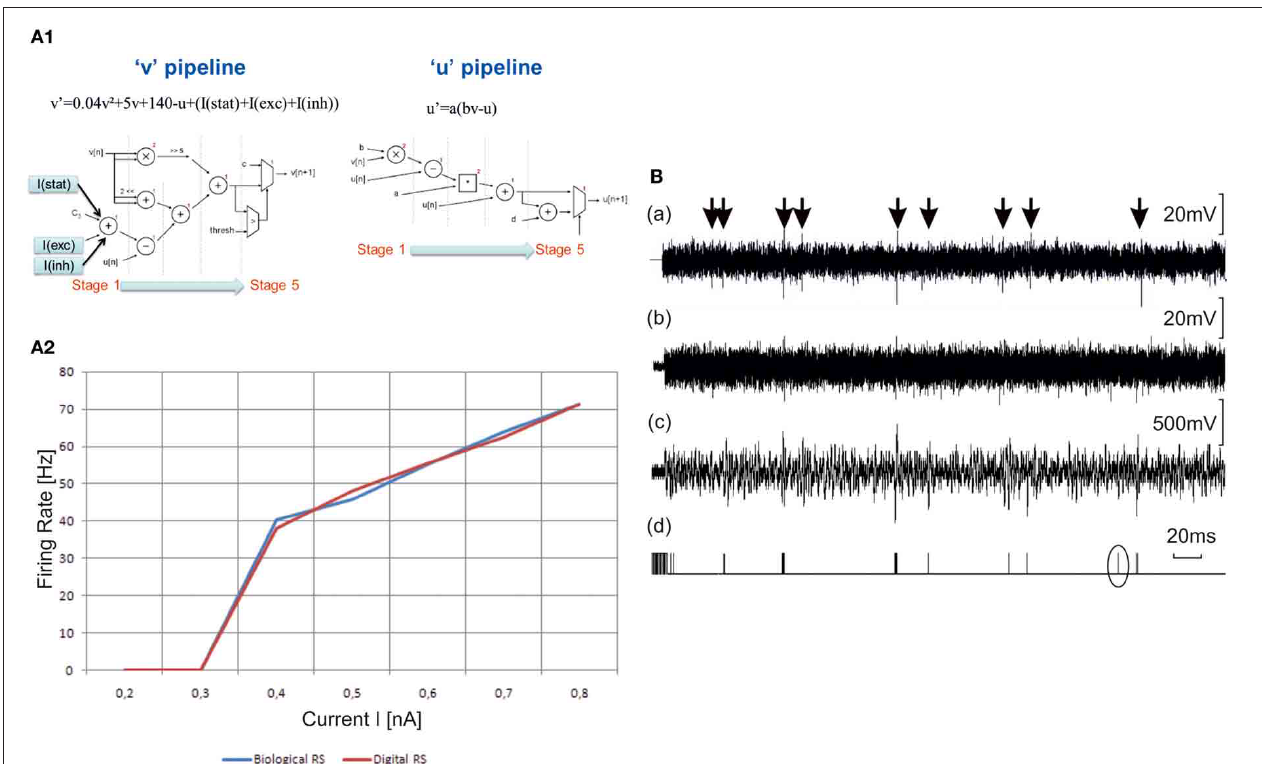
to Noise Ratio. This step was added to stress the capability of the system to detect action potentials in difficult conditions. Third row—(c) . Output of the stationary wavelet decomposition preprocessing module. We used a Haar mother wavelet with 16 bits fixed point computation. The output signal is the sixth level detail output of the decomposition tree. Fourth row—(d) . Binary output of the detection module. This output is the result of a threshold applied to the signal in (c). The threshold is computed from the standard deviation of the first level detail output of the wavelet decomposition tree. The emphasized detected spike is a false positive. This shows that the signal (b) represents the limit of signals that can be reliably processed by our system. These signals were first recorded then input to the system with a waveform